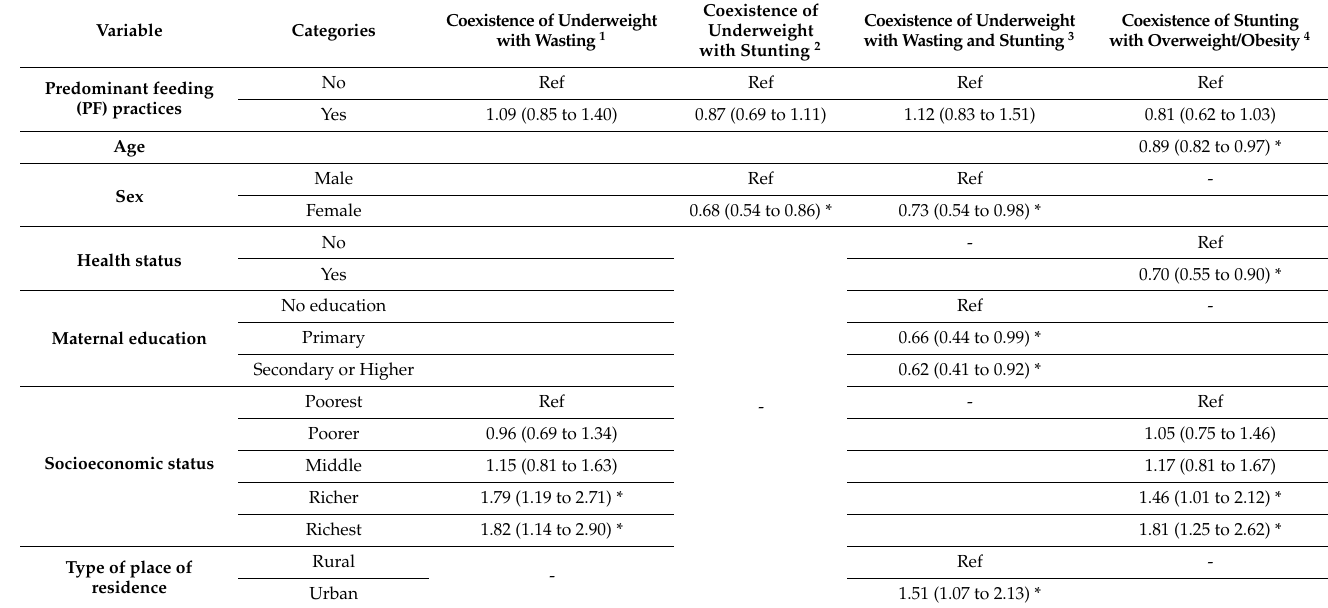
Table 3. Multinomial adjusted model for the associations between predominant feeding and